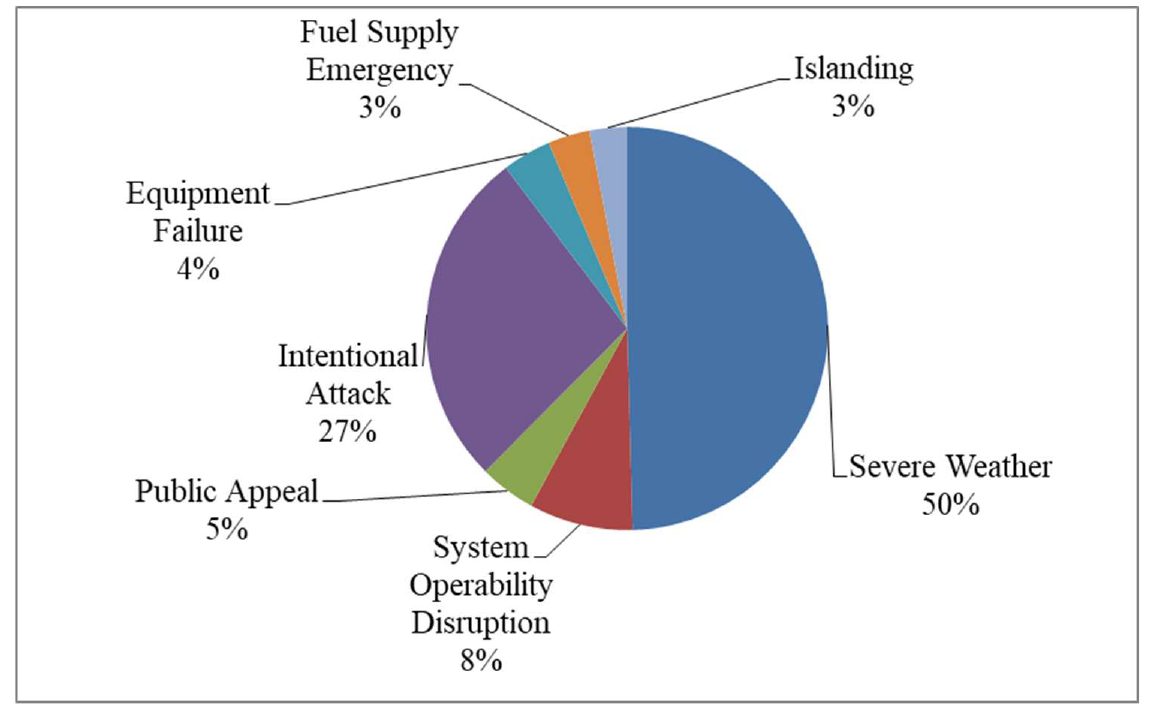
Figure 1. Occurrence of different events in percentage which caused the power outage [35].